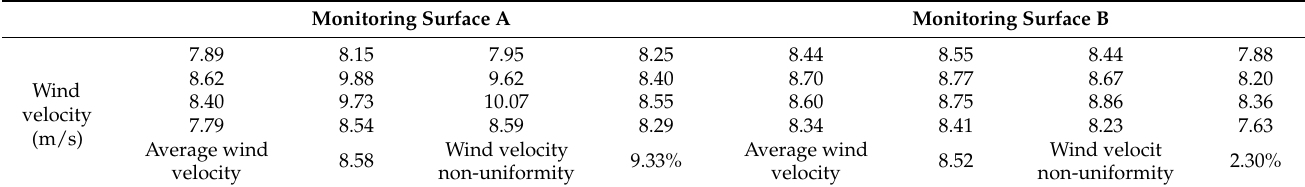
Table 1. Average wind velocity and non-uniformity of wind velocity at each point on the monitoring surface.